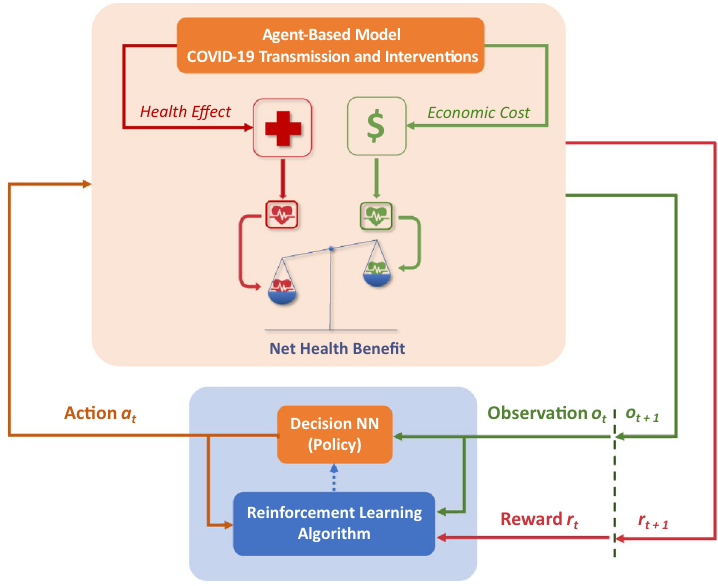
Figure 6. RL-based framework for optimising cost-effectiveness of SD